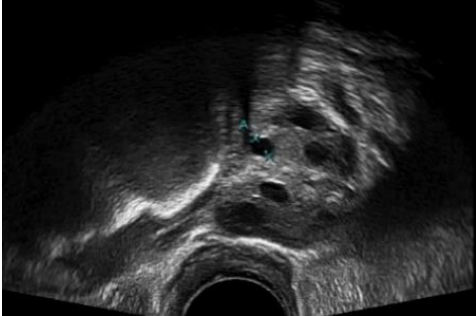
Figure 7. Original ultrasound acquired from the HCTM MAC unit.